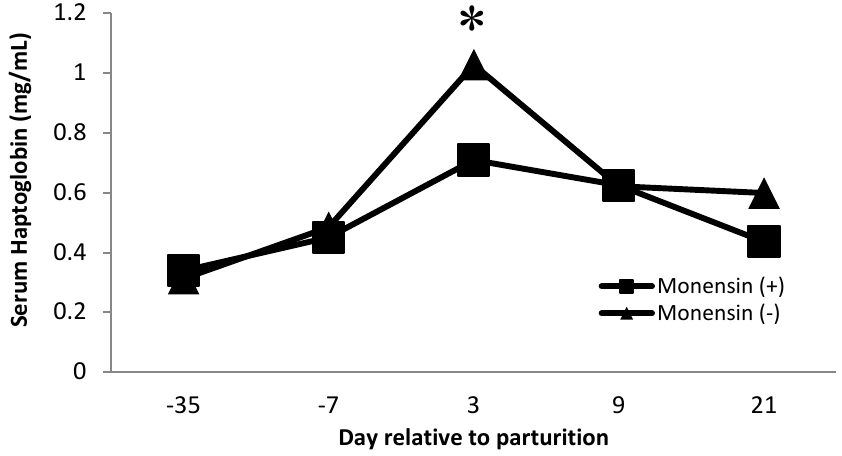
Figure 3. Serum haptoglobin concentration for multiparous Holstein dairy cows ( n = 80, total) that were fed diets with crude protein levels (10.3%, n = 40 vs. 12.2% dry matter basis, n = 40), and within each crude protein group fed monensin (400 mg/day per head or none) and vitamin A (110 IU/kg body weight or none) during prepartum period (from day − 35 to the day of calving). All cows re- ceived a common lactation ration postpartum. Dietary monensin × time interaction ( p = 0.01). Aster- isks show significant differences at time point specified.